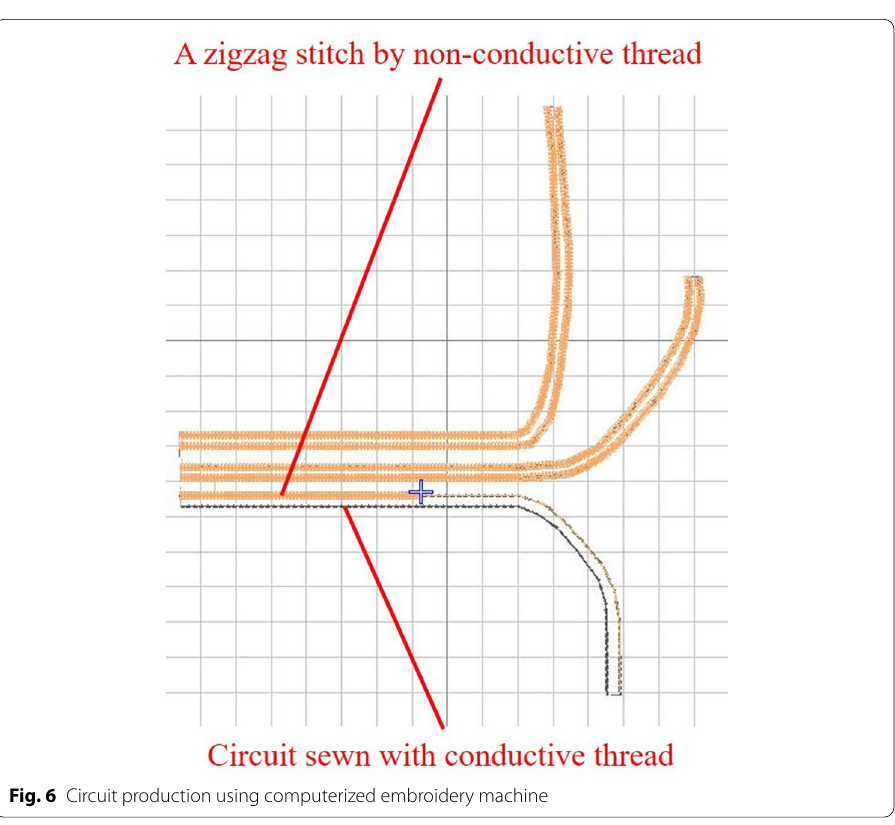
Fig. 6 Circuit production using computerized embroidery machine